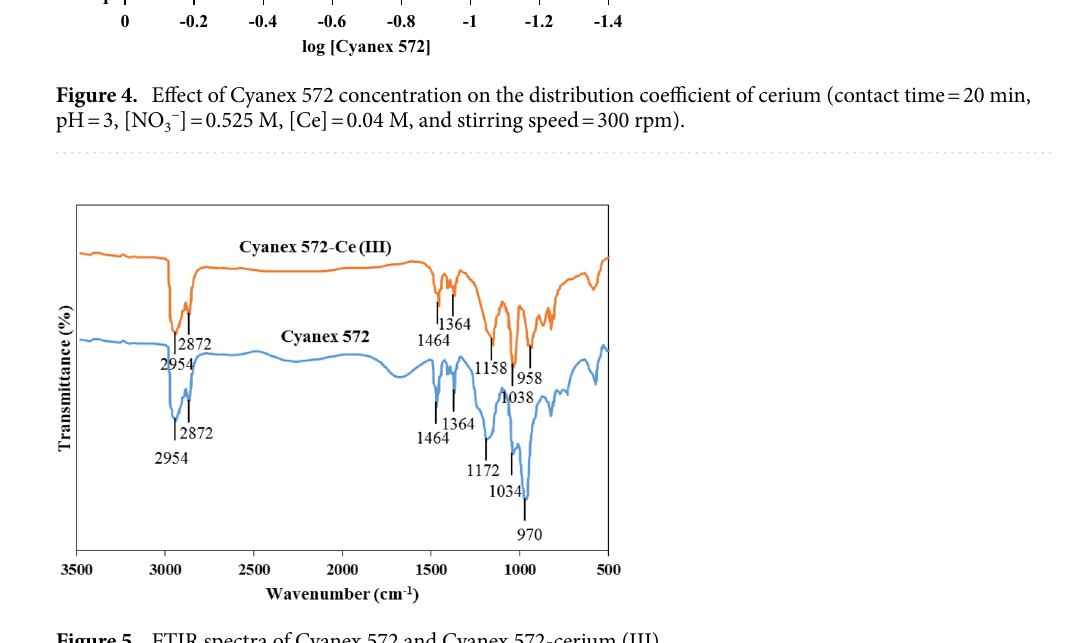
Figure 5. FTIR spectra of Cyanex 572 and Cyanex 572-cerium